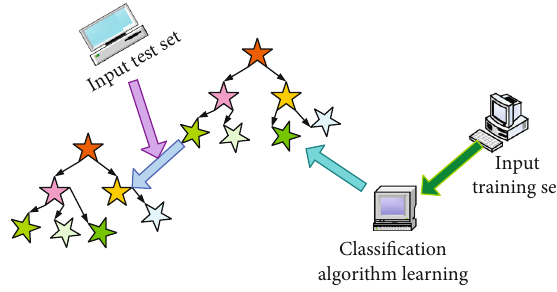
Figure 1: Decision number generation